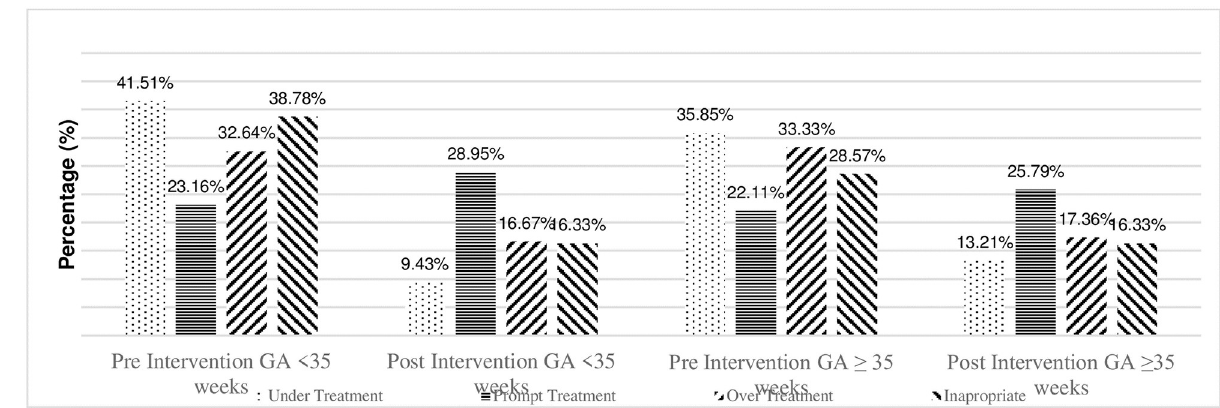
Fig 4. Treatment classifications before and after the introduction of BiliNorm based on gestational age. Proportions of infants with a gestational age below (grey bars) or above (black bars) 35 weeks with inappropriate treatment, under-treatment, over-treatment and correct treatment before (hatched bars) versus after (solid bars) the introduction of BiliNorm. � : p < 0.05 before versus after introduction.